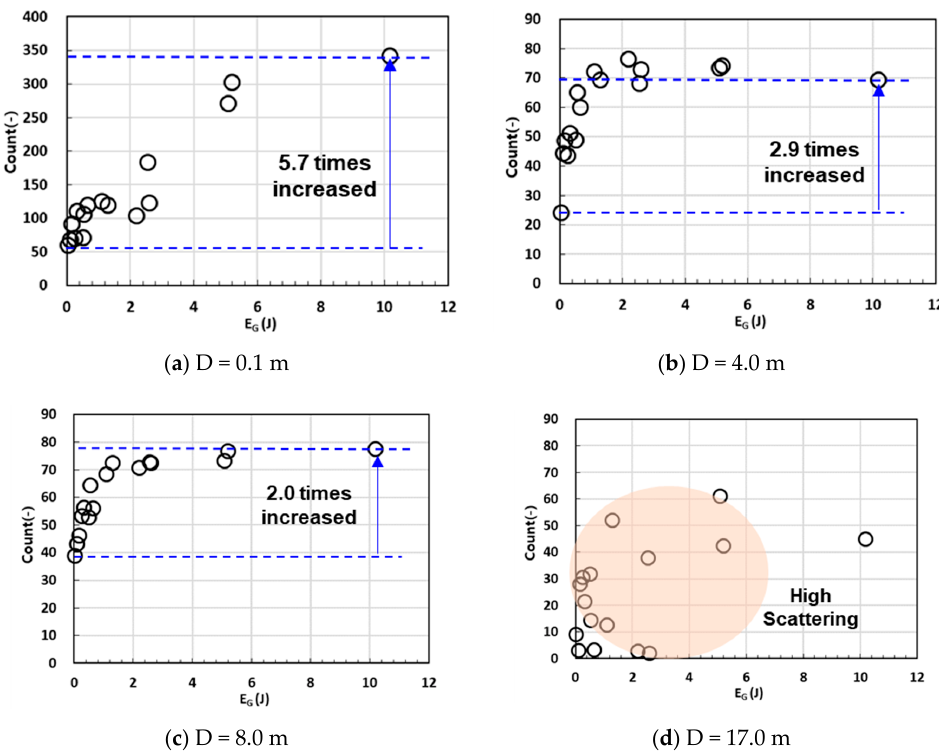
Figure 6. Count according to impact energy.